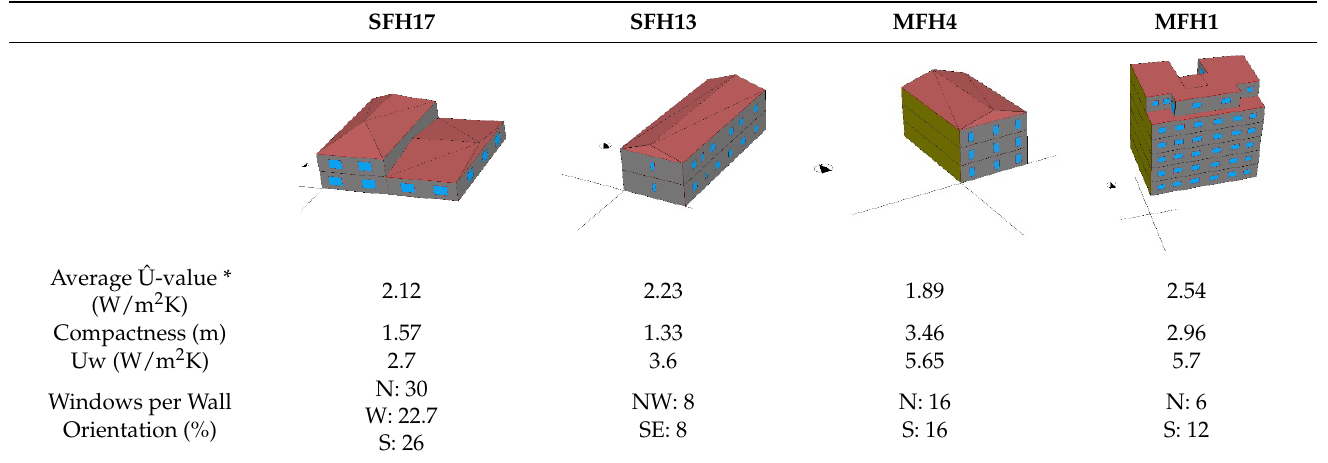
Table 2. Type of POS according to the climatic zone and type of reference building. Climatic